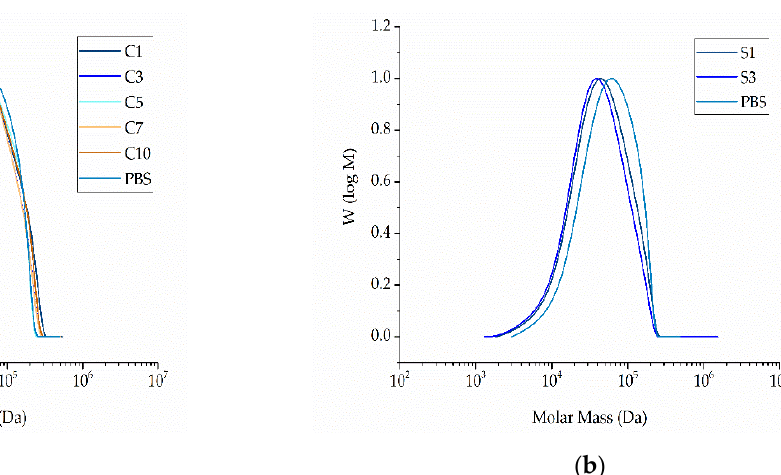
Figure 20. Molar mass distribution curves. ( a ) Fibers composed of PBS compounds with increasing weight percentages of curcumin. ( b ) Fibers composed of PBS compounds with increasing weight percentages of silver. All fibers were prepared by melt electrospinning at 235 °C and 60 kV, with a nozzle-to-collector distance of 10 cm and a throughput of 0.1 mL/min.